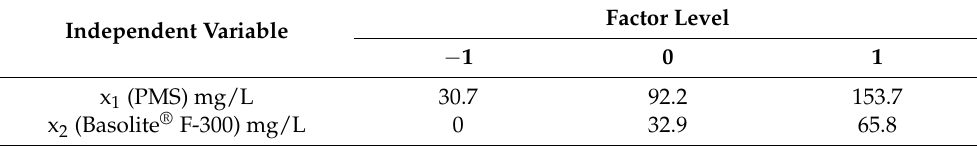
Table 1. Factor levels of the two independent variables selected for the experimental design. Independent Variable